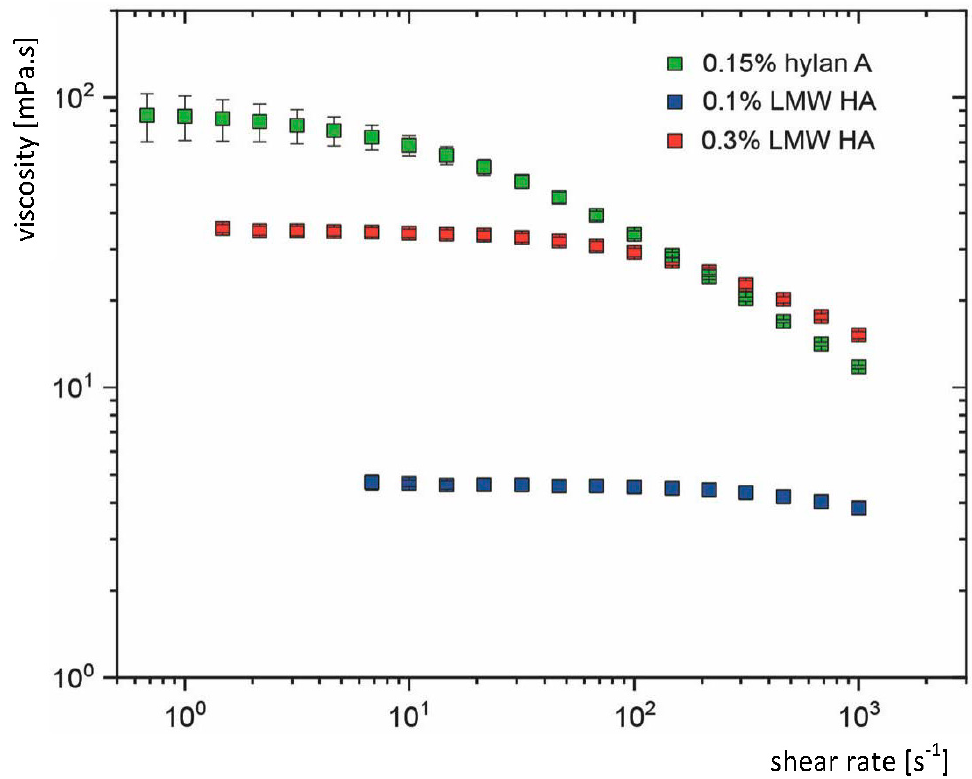
Figure 3. Flow characteristics of eye drops containing different average molecular weight and concentration of hyaluronan.